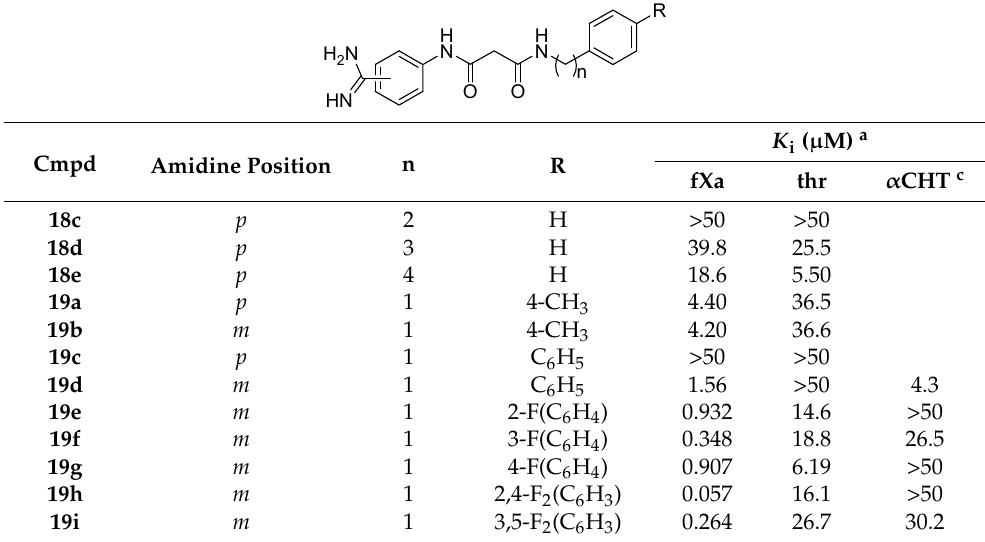
Table 2. Activity of N 1 -(amidinophenyl)- N 3 -benzylmalonamides on fXa and thr.